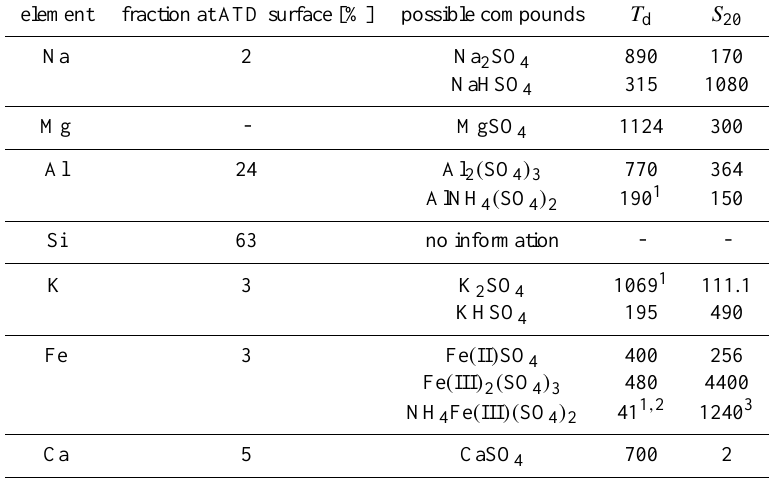
Table 2. ATD surface elemental composition from XPS as found by Vlasenko et al. (2005) and possible compounds formed with these substances. Mg is expected to be on the particle surface as it is found in the bulk material, but the XPS data was recorded with an Mg anticathode, masking the Mg of the sample. The list shown below is only a proposal for possible reaction products based on the availability of the respective material. We were not able to directly identify these compounds. The numbers in the two last columns indicate